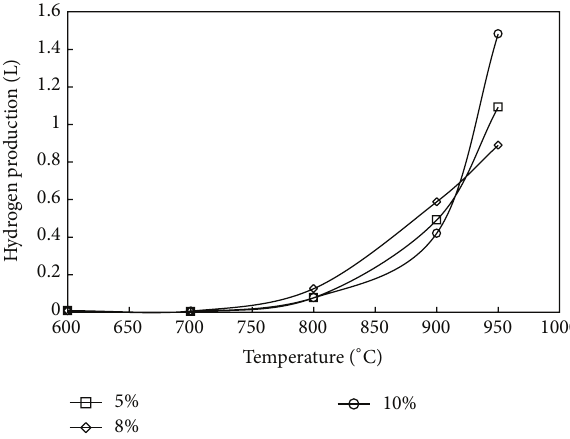
Figure 3: The XRD of different sliver loadings.